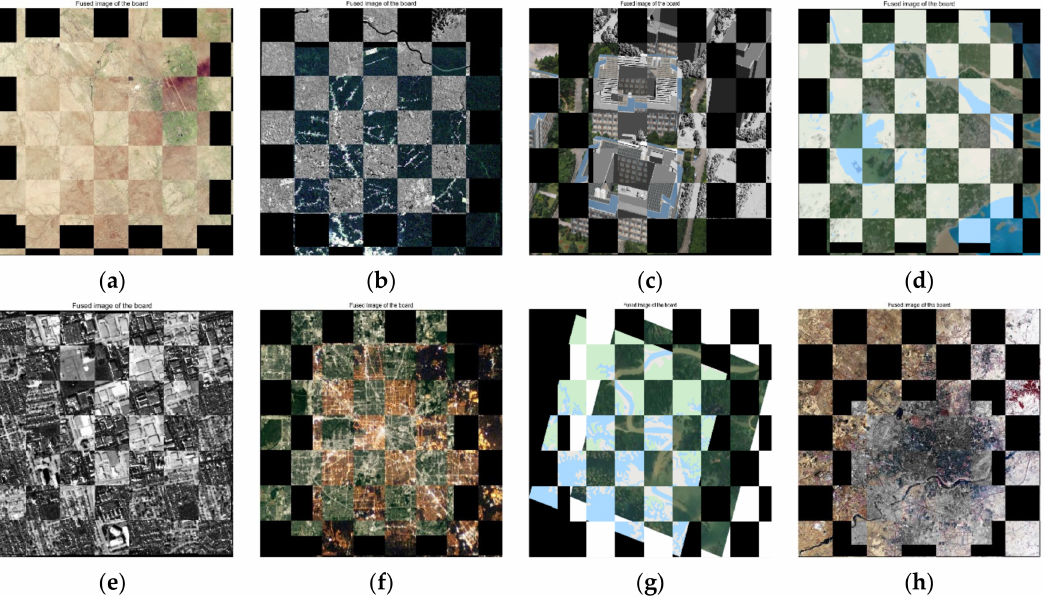
Figure 14. Registration effect of image pairs: ( a ) optical–optical; ( b ) optical–infrared; ( c ) optical–depth; ( d ) optical–map; ( e ) optical–SAR; ( f ) day–night; ( g ) rotation; ( h )